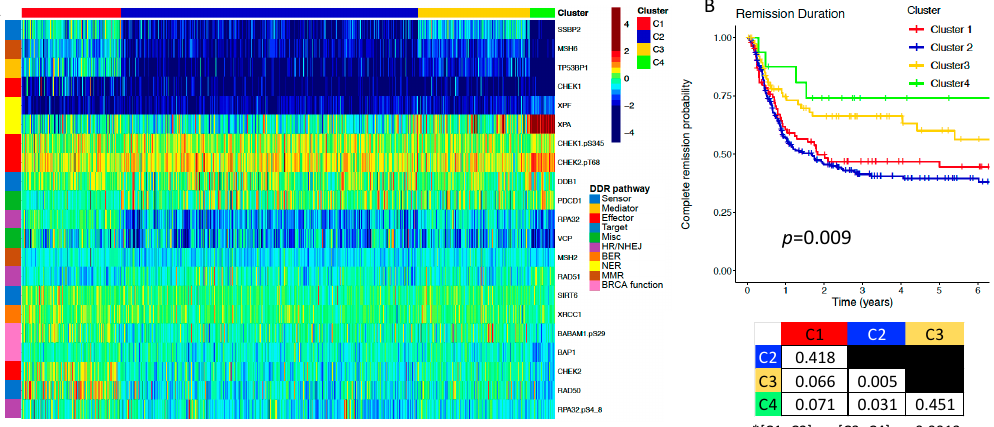
Figure 1. DDR proteins reveal four distinct clusters of adult AML patients with significantly different remission durations. ( A ) The core set of 21 DNA damage repair (DDR) proteins used to stratify AML patients into four separate clusters with significantly different remission durations (RD) are delineated as rows on the right side of the heatmap. The top of the heatmap indicates the cluster assignment (C1 − C4) for each patient, while the heatmap itself displays levels of DDR protein expression in all patients. Proteins downregulated in expression relative to normal CD34+ cells are colored in cooler colors approaching deep blue, while upregulated proteins are colored in warmer colors approaching burgundy, as indicated by the color scale located at the top right of the heatmap. ( B ) The color of the remission duration curve for each cluster corresponds to the color band at the top of the heatmap ( n = 398). Below the RD curves is a table displaying statistical comparisons and associated p − values between each individual cluster as well as [C1+C2] vs. [C3+C4].